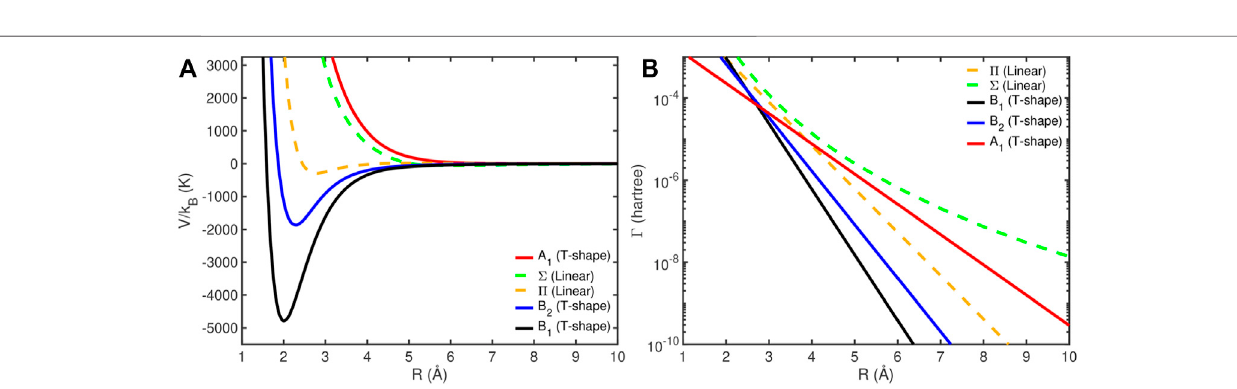
FIGURE 10 | The reaction rates for the He( 3 S,1s2s) + H 2 collision. Panel (A) for H 2 in its rotational ground state (para) and (B) in its fi rst excited state (ortho). The peaks are associated with nuclear resonances of the He* − H 2 supermolecule. Reprinted (adapted) with permission Ref. [67]. Copyright (2017) American Chemical Society.